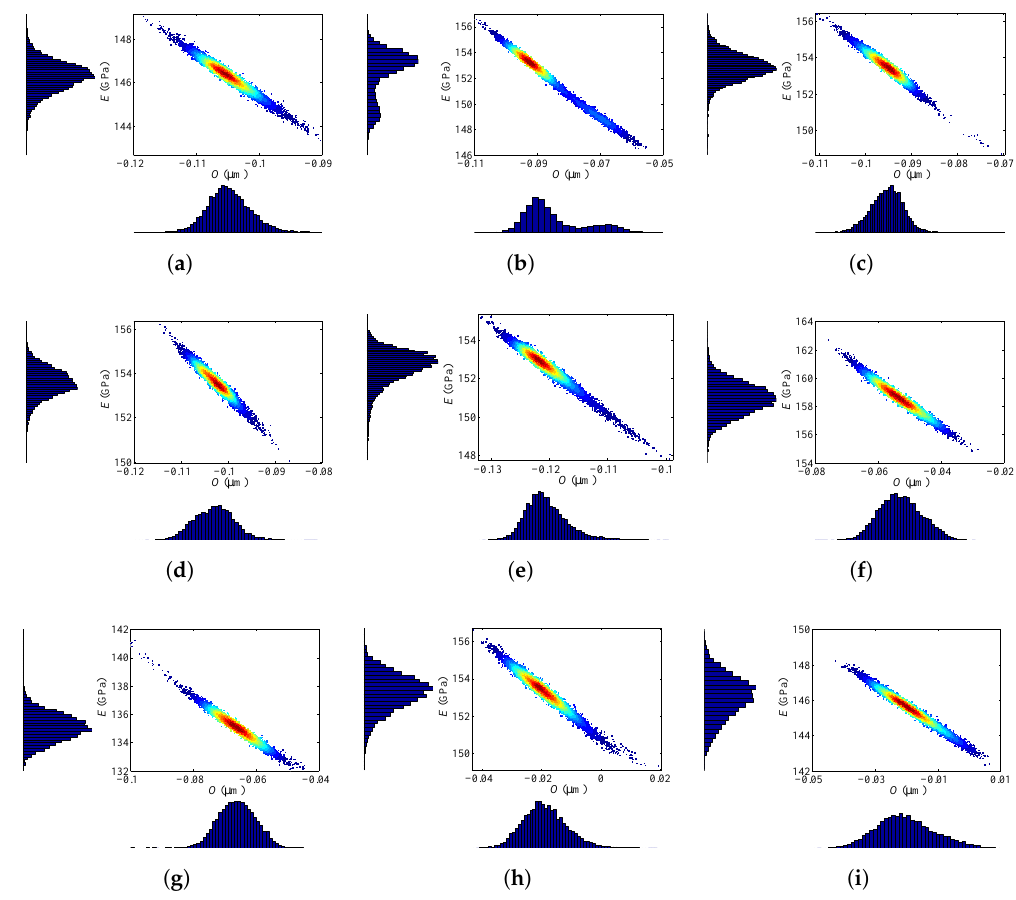
Figure 7. Scattering of the TMCMC samples, and corresponding histograms (reported on the bottom and left sides of each plot) of the model parameter distributions for devices ( a ) #1 to ( i )